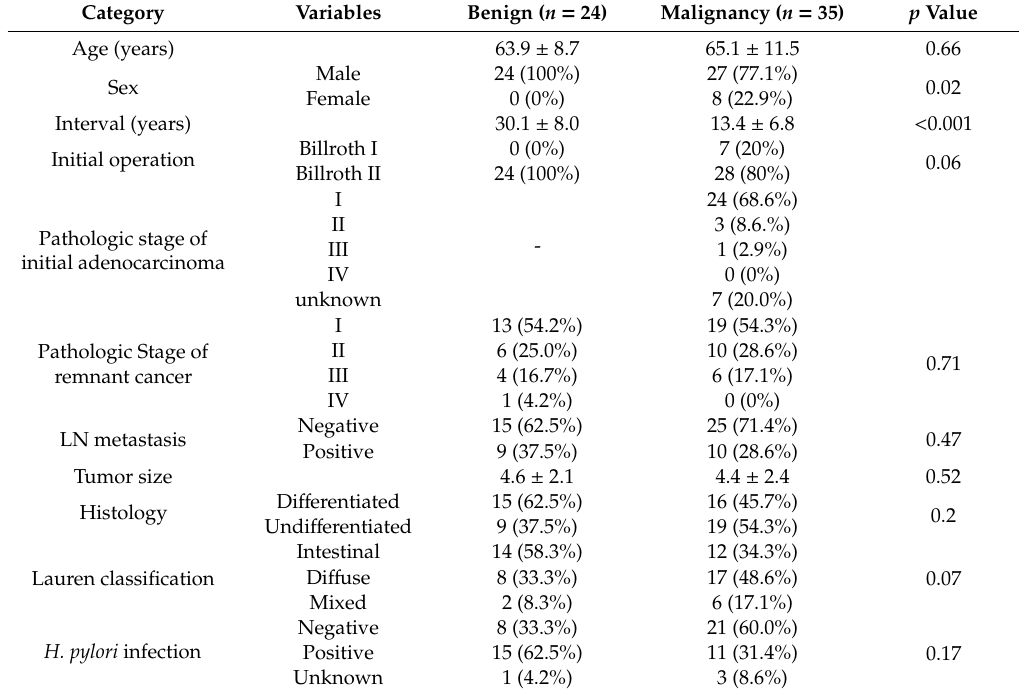
Table 1. Patient demographic.